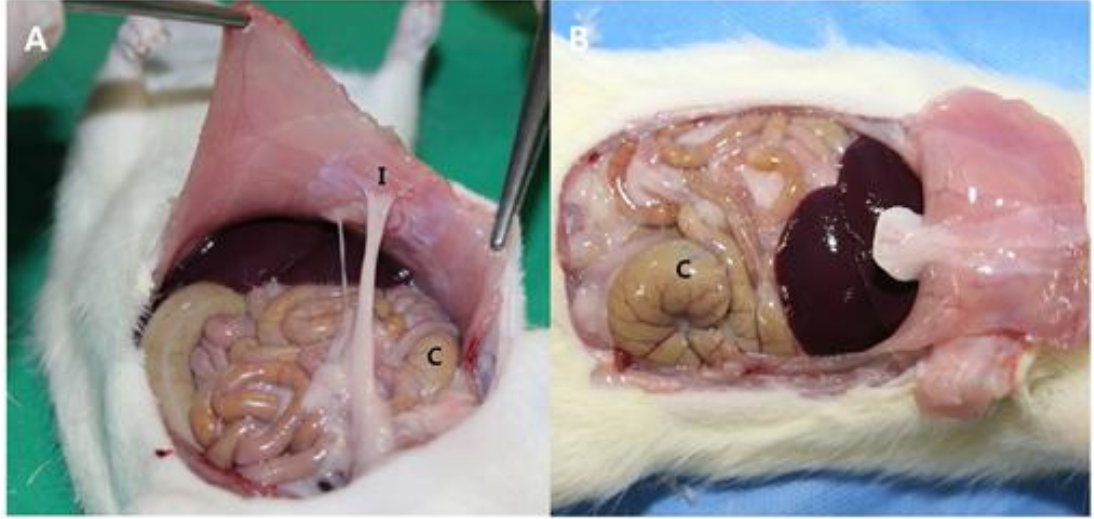
Figure 9. Photographs of the test group. ( A ) Adhesions between the incision in the abdominal wall and other tissues can be observed. ( B ) There are fewer adhesions between the cecum and abdominal wall. Note: “C” represents cecum, and “I” represents incision site. Table 2. Presence of adhesion in the rat cecum abrasion model.